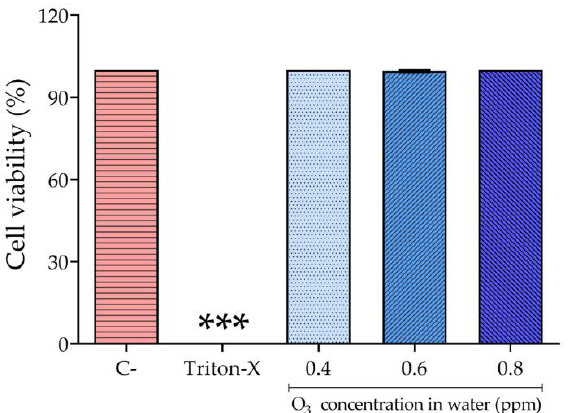
Figure 9. The behavior of Hfib cells upon ozonized water exposure. The different concentrations of ozonized water are displayed in the figure. C- represents the cells that were exposed to the medium only and 10% Triton-X was used as the positive control (cell death); ***Statistical difference between the positive control and the different concentrations of ozonated water.